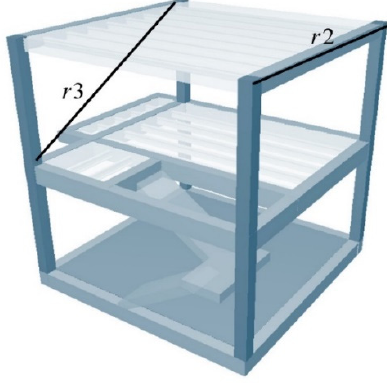
Figure 10. Model sketch III. Figure 11. Model sketch III.